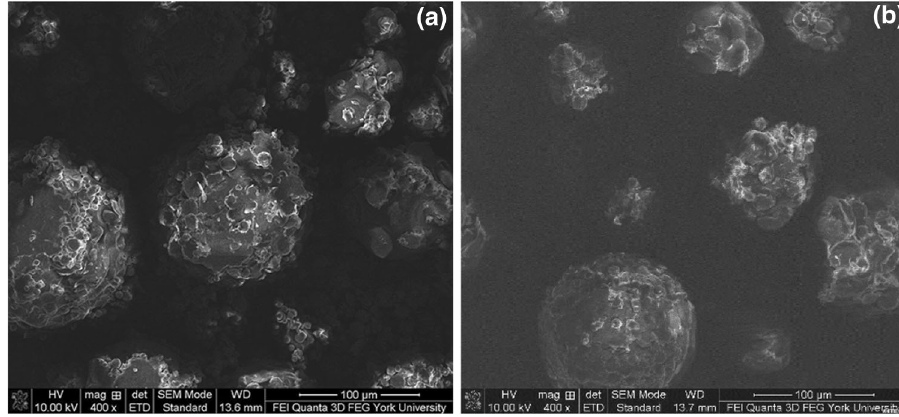
Fig. 6 SEM micrographs